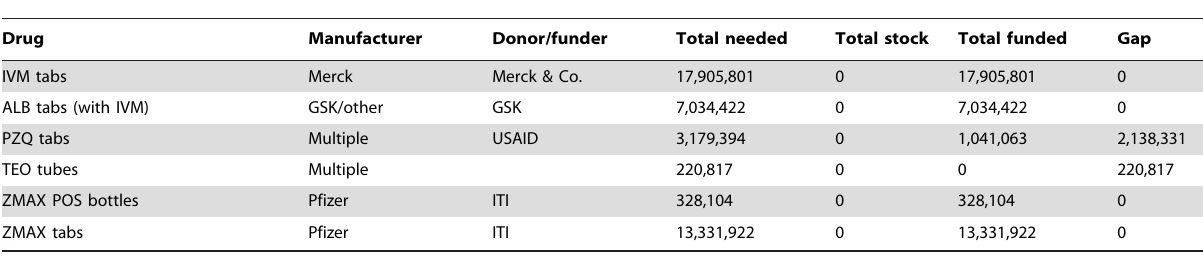
Table 6. Tanzania drug acquisition (in drug units,* FY Oct. 2010–Sept. 2011).**